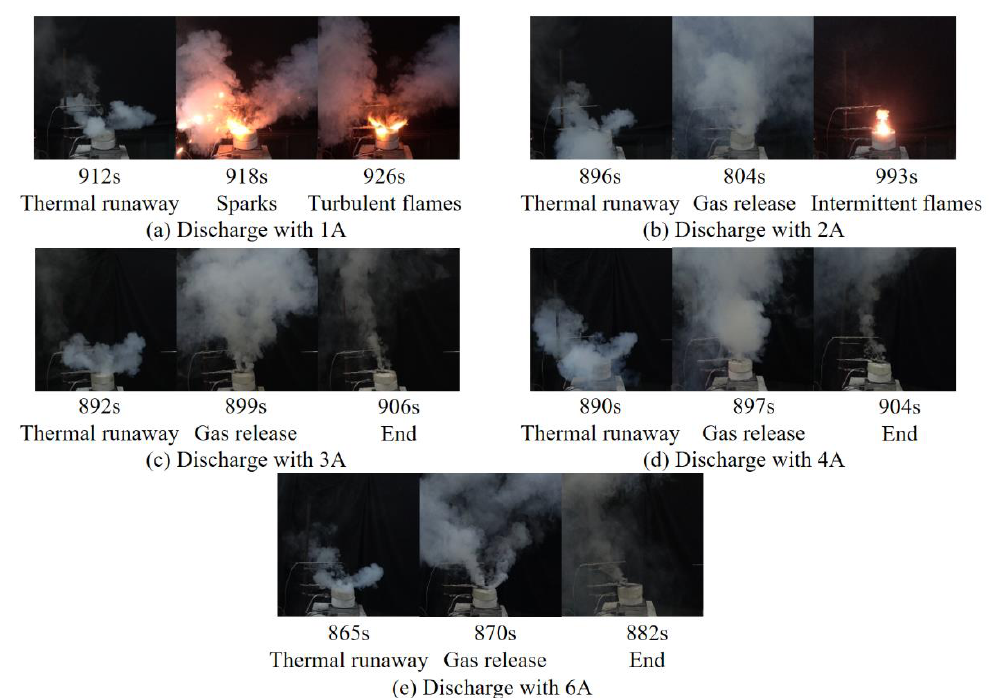
Figure 3. Thermal runaway behaviors under different discharge currents in Group ii. ( a ) The LIB discharge with 1 A; ( b ) The LIB discharge with 2 A; ( c ) The LIB discharge with 3 A; ( d ) The LIB discharge with 4 A; ( e ) The LIB discharge with 6 A.